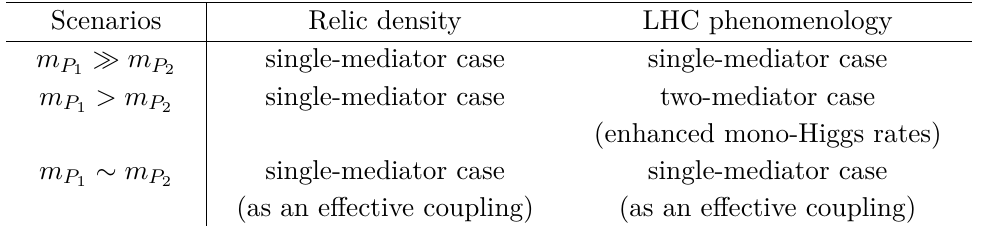
Table 1 . Model description and main phenomenological consequences as a function of the mass splitting between the two